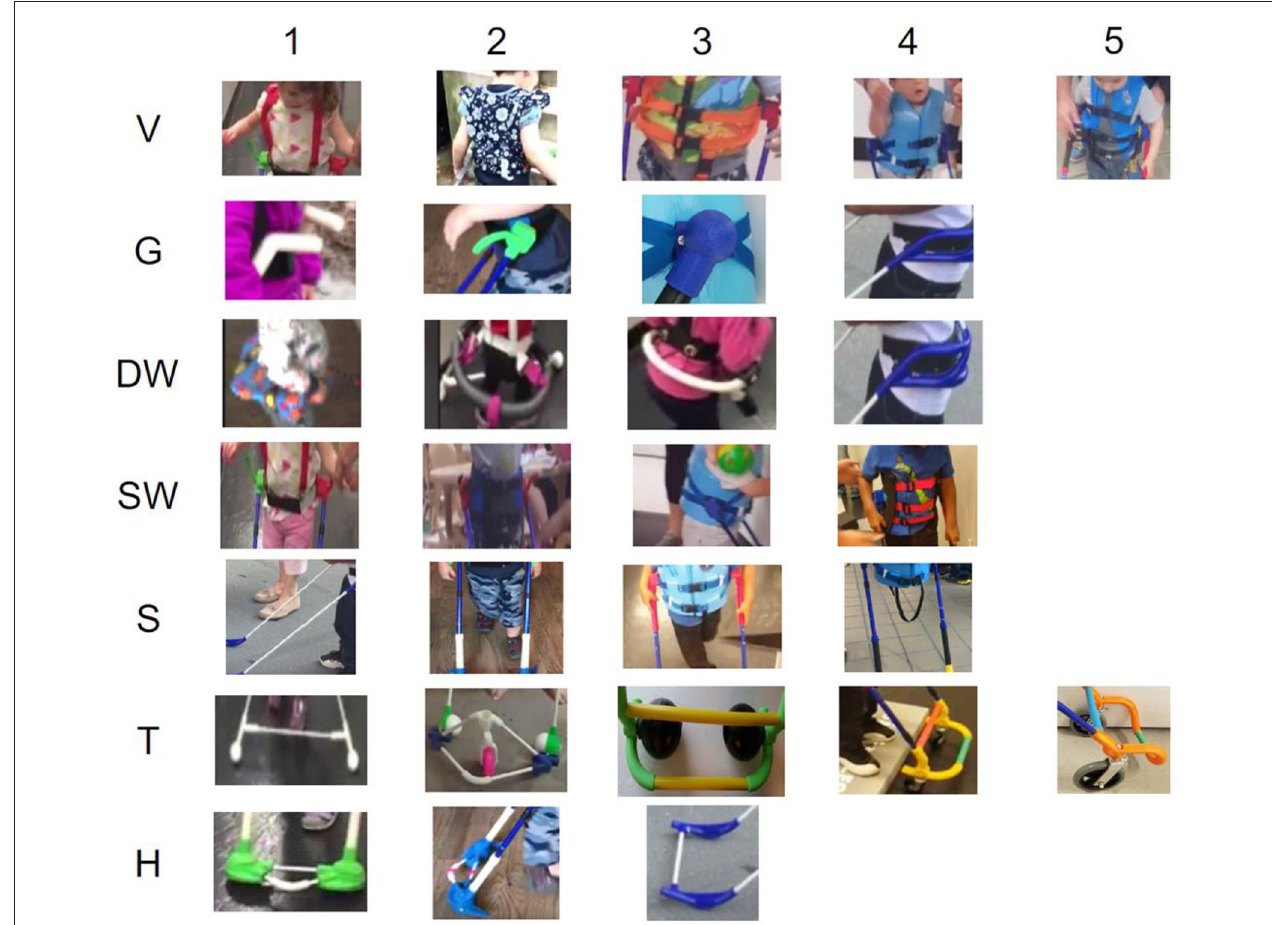
FIGURE 1 | Design components used during the rapid prototyping phase.